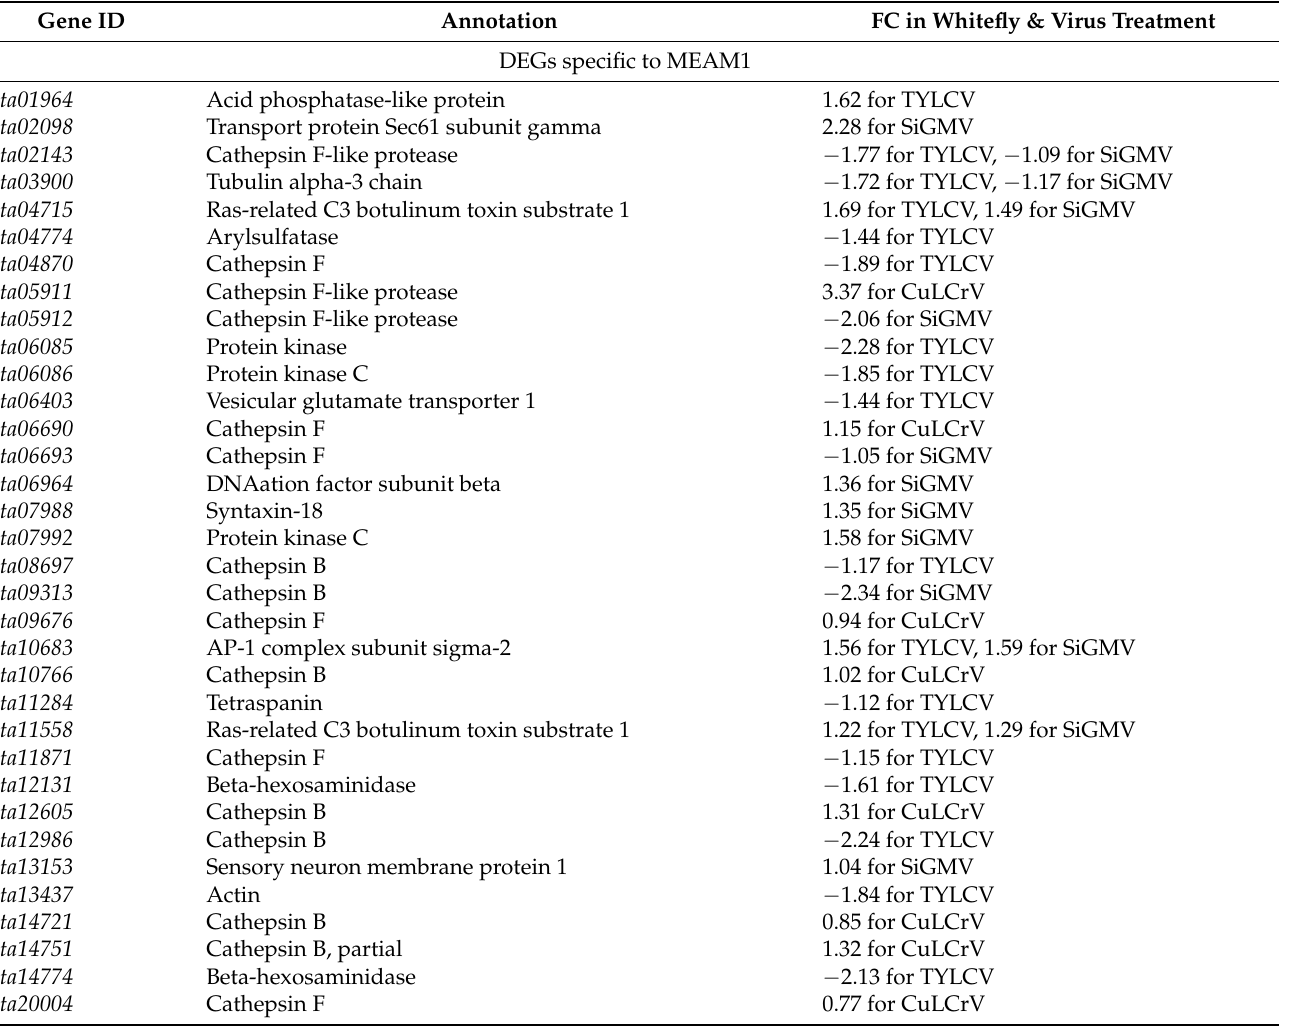
Table 5. Differential expression of genes associated with cellular processes (apoptosis, lysosome, and phagosome) in viruliferous compared with non-viruliferous Bemisia tabaci Middle East-Asia Minor